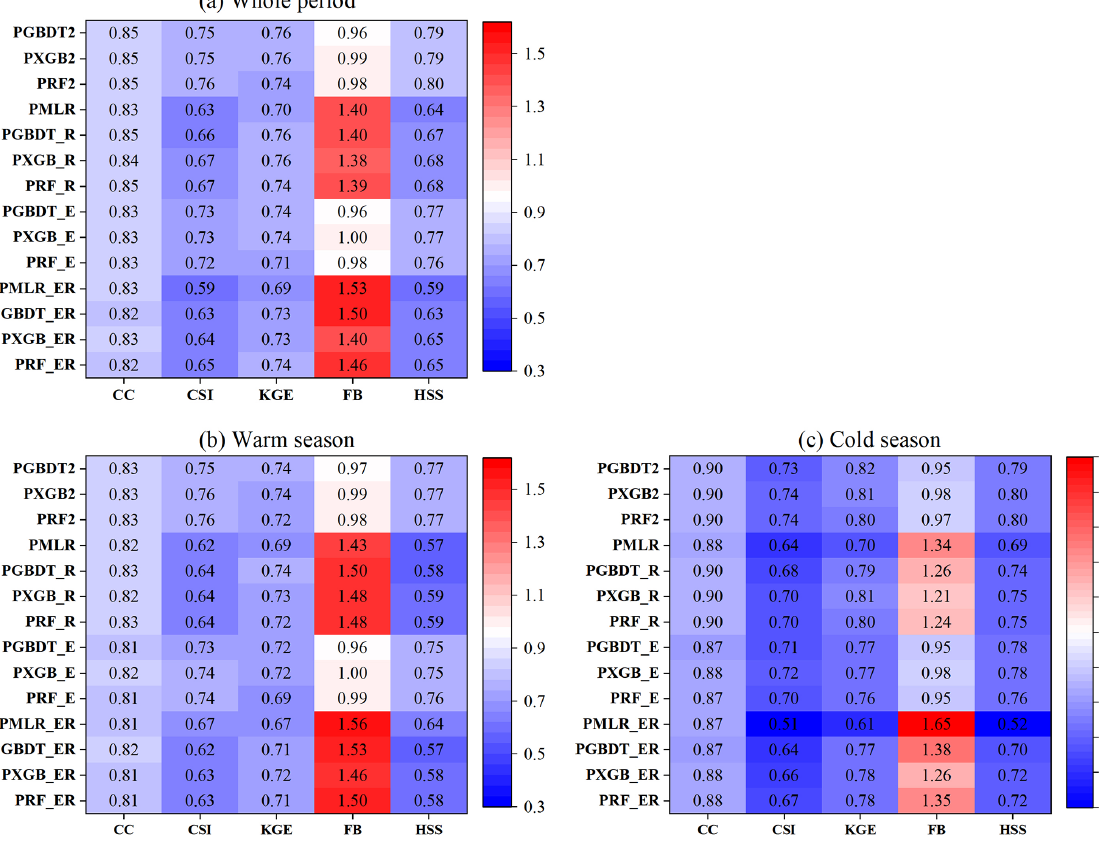
Figure 11. Five evaluation metrics (CC, CSI, KGE, FB, and HSS) for different products under four scenarios during the whole period (a) , warm season (b) , and cold season (c)